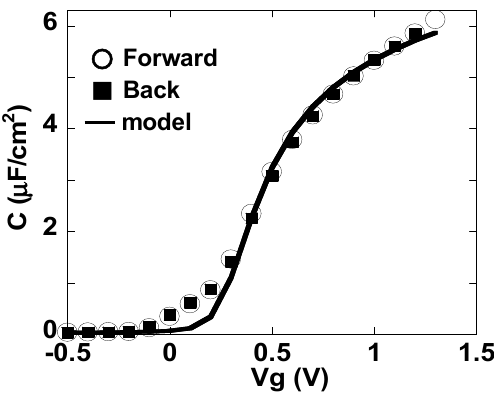
Figure 4. Jg-Vg characteristics of the MIS capacitor shown in Figure